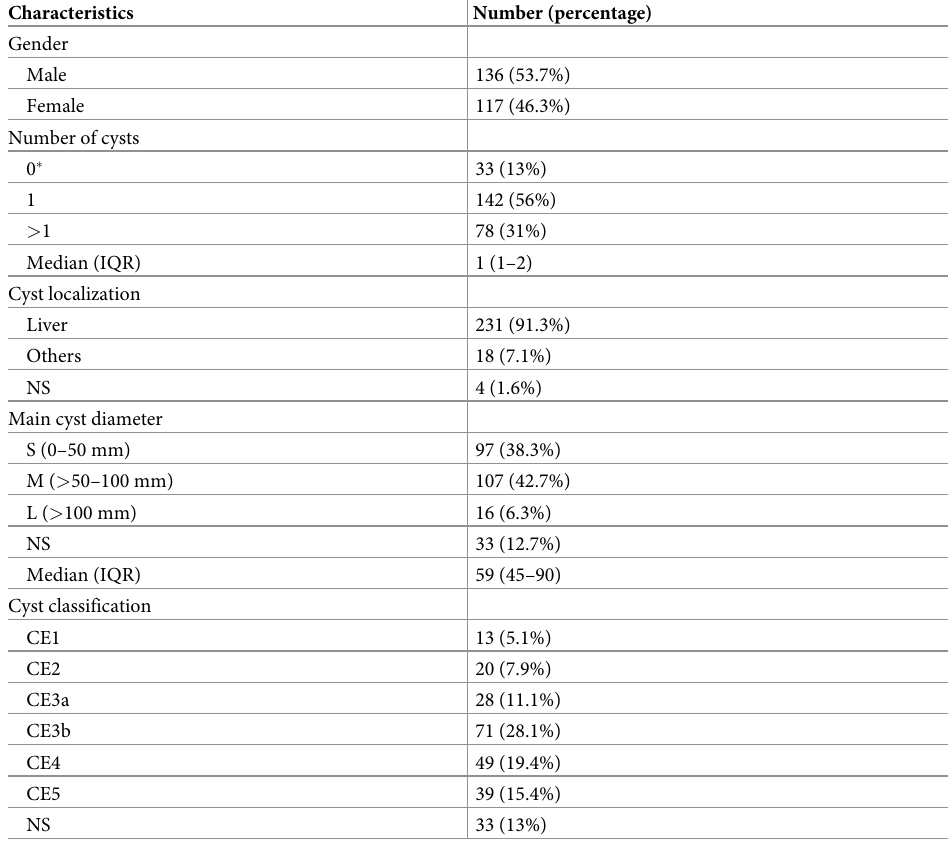
Table 1. Demographic and clinical characteristics of patients with CE.